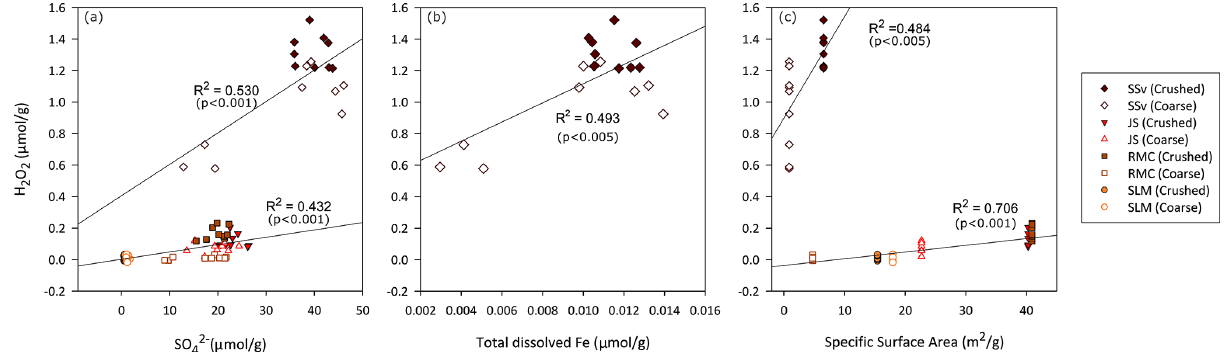
Figure 2. Relationships between concentration of H 2 O 2 (µmol) produced per gram of crushed and coarse rock and sediment samples relative to (a) sulfate in solution, (b) iron in solution and (c) specific surface area of samples. The concentrations of H 2 O 2 , sulfate (a) and dissolved Fe (b) measured in solution are normalised to gram of sample and treated as one population throughout the 25h of incubation. Note that Fe concentrations were above detection limits only in the SSv samples. R 2 and p values obtained from linear regression model in